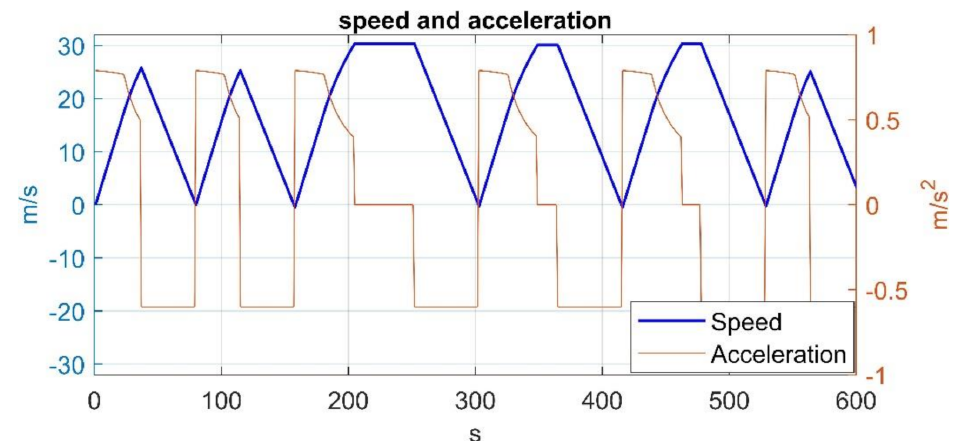
Figure 4. Speed and acceleration plot over